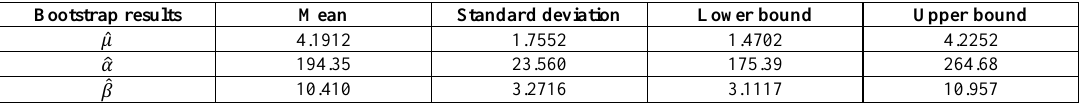
Table 5. Results for the parametric bootstrap applied to EME